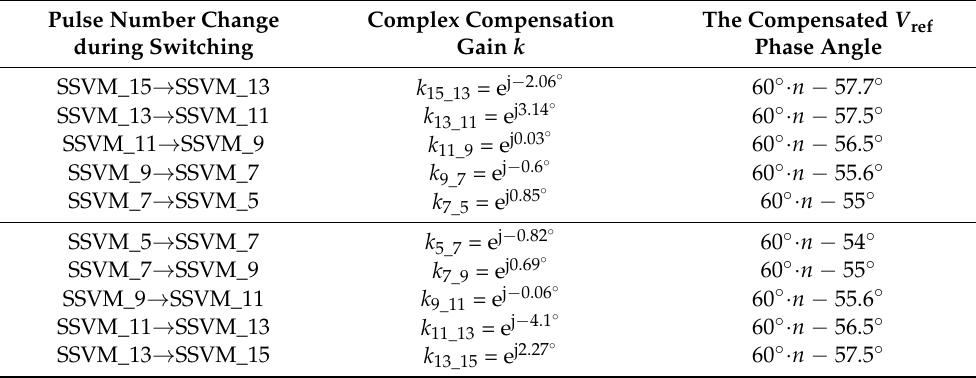
Figure 7. Flux trajectories Change rate of SSVM_9 and SSVM_7. The calculation method of complex compensation gain k for switching between other pulse numbers in multi-mode SSVM method is the same as the above process. Due to space limitations, the calculation process is not listed step by step, the calculation results are shown only in Table 3, and the flow block diagram of the smooth switching method is shown in Figure 8. According to Figure 8, the proposed smooth switching strategy first needs to calculate the flux trajectories before and after switching according to Equations (2)–(4); Then, draw flux trajectories change rate, such as Figures 6 and 7, and the value of k is calculated; Finally, according to the value of k in Table 3, the reference voltage vector phase angle is compensated. Table 3. Complex compensation gain k calculation